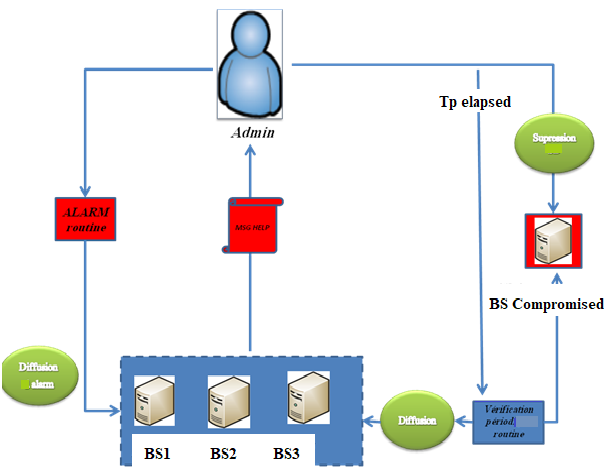
Figure 6 . Diagram for the detection of a compromised BS node - Scenario with several BSs